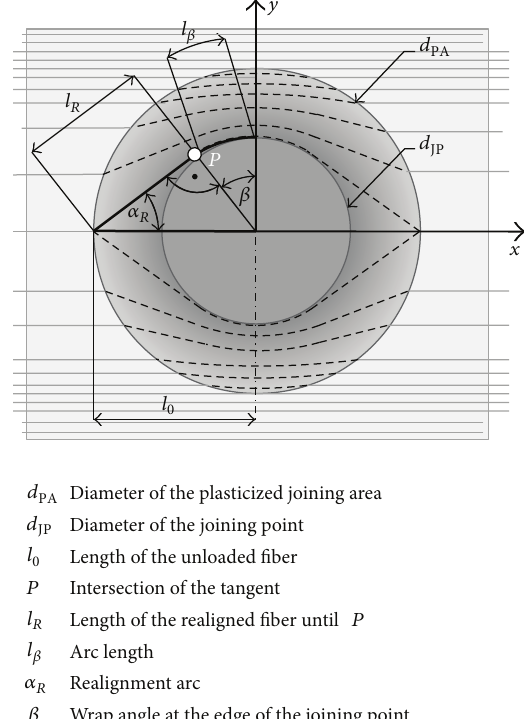
Figure 6: Geometric model description of an unidirectional ply withthemostdeflectedfiberandrequireddiameteroftheplasticized joining area.